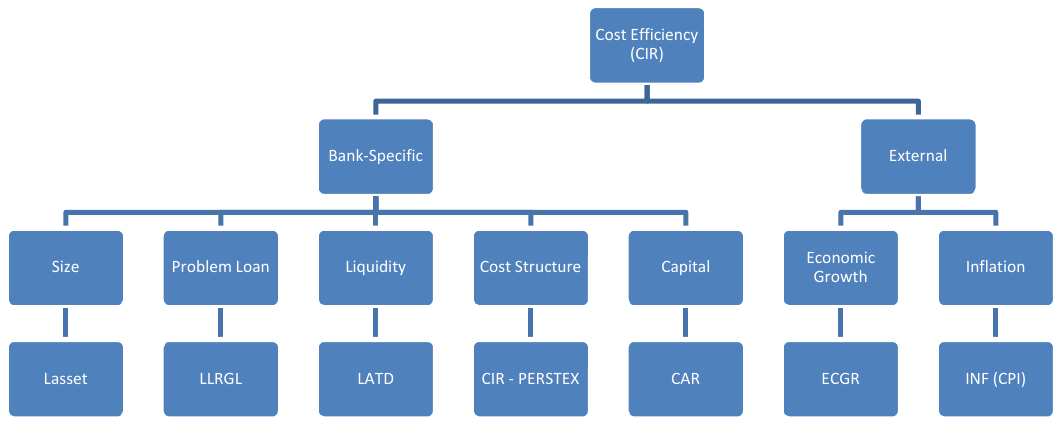
Fig. 1. Research framework